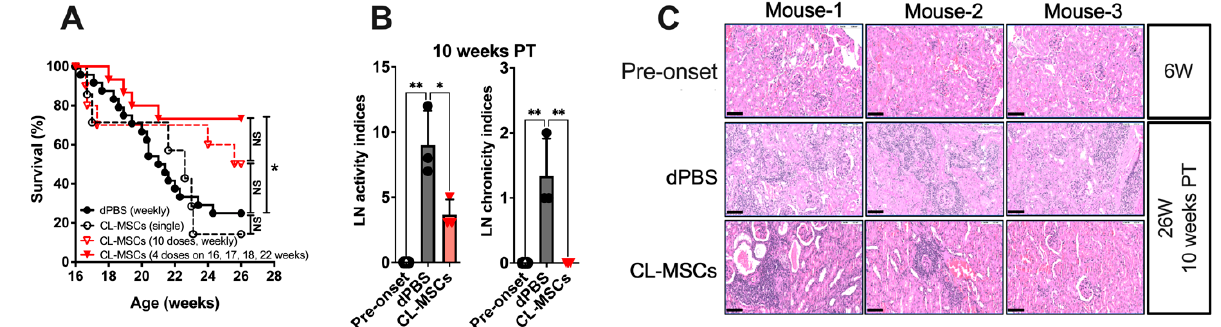
Figure 1. Intraperitoneal CL-MSCs were able to improve mice survival and reduce disease activity : ( A ) Survival curves of Fas lpr mice treated with single and multiple doses of CL-MSCs. Twenty-four, 15, 7, and 10 mice were used in dPBS control, CL-MSCs (a total of 4 doses on 16-week-old, 17-week- old, 18-week-old, and 22-week-old mice), and CL-MSCs (single dose on 16-week-old mice) and CL-MSCs (a total of 10 doses weekly) groups. ( B ) Histopathological evaluation of LN activity and chronicity at 10 weeks PT. Three mice per group. ( C ) H&E staining. Kidney sections from each group at 10-week PT. Scale bar: 100 μ m. Results were expressed as mean ± SD. For multiple comparison, the significance was defined as * p < 0.025; ** p < 0.005 when n = 2. One-way ANOVA Dunnett’s test was used for multiple comparison with 95% confidence interval.